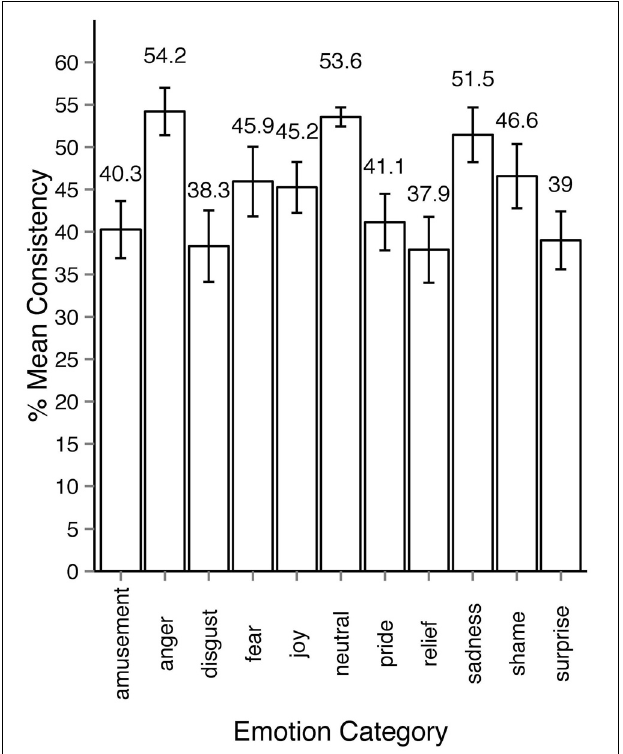
FIGURE 6 | Average consistency levels across emotion categories in experiment 2. The sequences are assigned emotion labels according to the modal category in observers response distribution. All error bars show 95% confidence